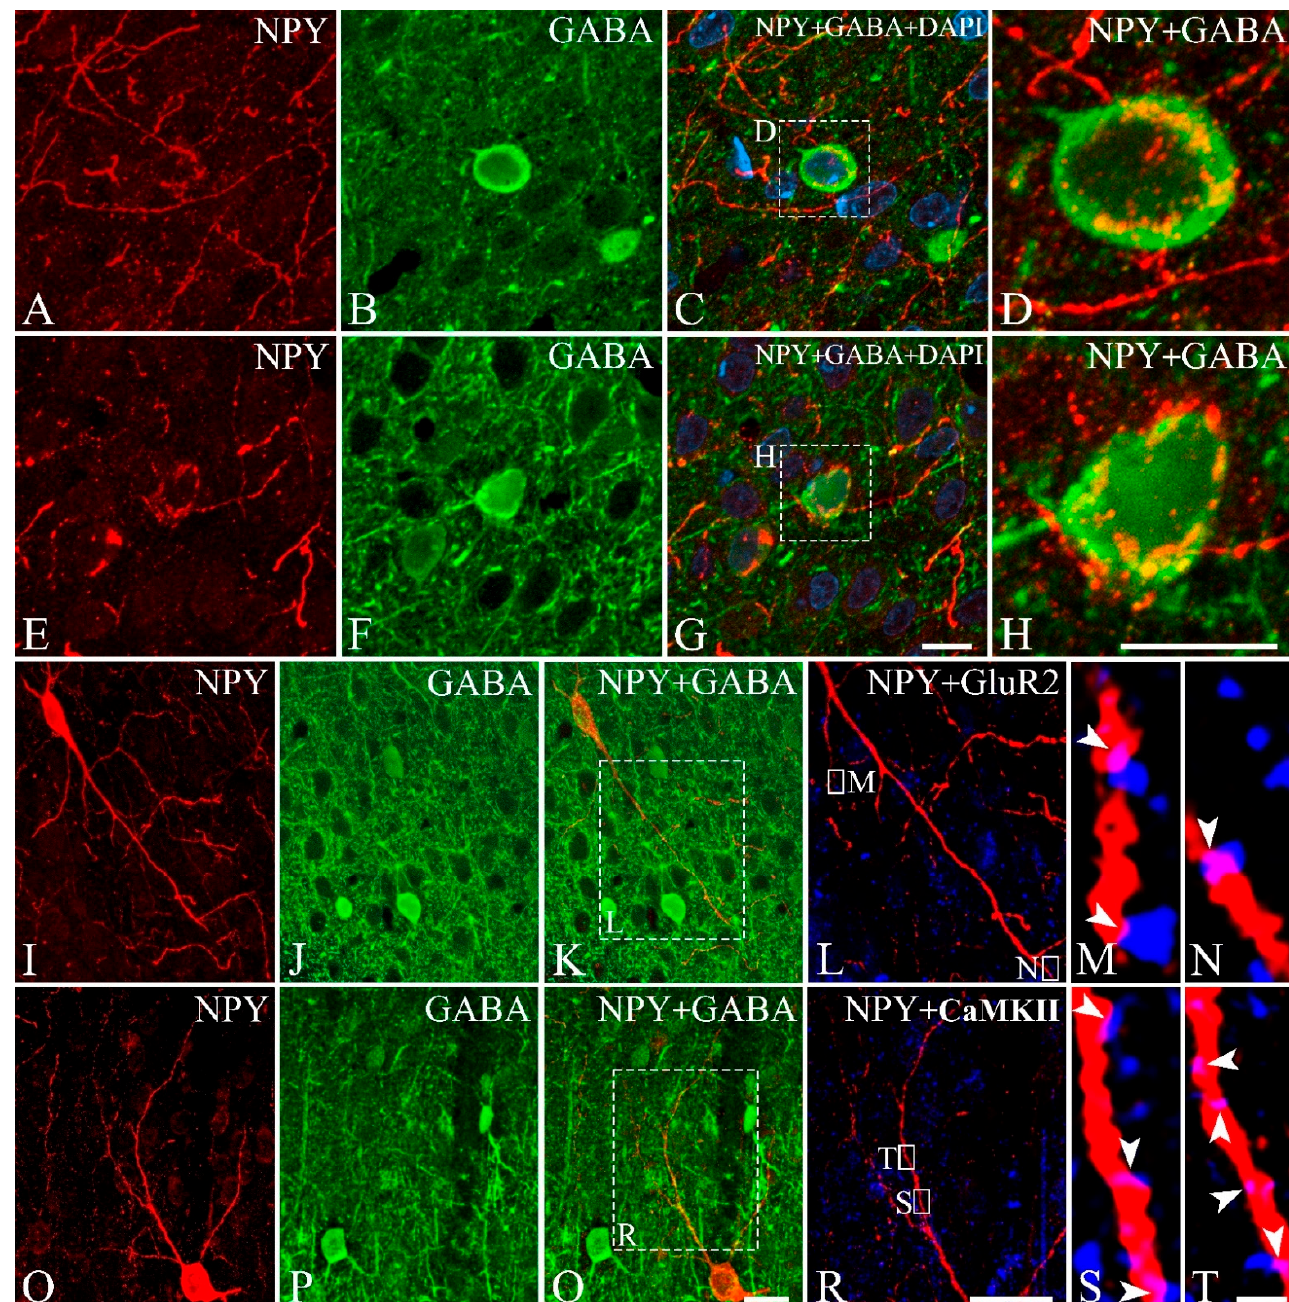
Figure 4. Double- and triple - labeling of NPY with GABA and GluR2 or CaMKII in the gerbil visual cortex. Expression of NPY (red, A , E , I , O ), GABA (green, B , F , J , P ), and GluR2 or CaMKII (blue represents the false color image of infrared fluorescence) in gerbil visual cortex. ( C , G ) Merged images of fluorescence NPY-IR fibers and GABA-IR neurons with 4 ′ ,6- diamidino-2-phenylindole (DAPI) staining. ( D , H ) Magnified images of boxes in C and G showing NPY-IR fibers surrounding the somata of GABA-IR neurons. ( K , Q ) Merged images of NPY-IR neurons which are not GABA-IR neurons. Magnified images of boxes in K and Q showing localization of NPY-IR fibers and GluR2- ( L ) or CaMKII-IR puncta ( R ). ( M , N , S , T ) Highly magnified images of boxes in L and R. NPY-IR fibers show colocalization (arrowheads, light pink) with GluR2- ( M , N ) or CaMKII-IR immunopuncta ( S , T ). A set of images NPY-IR fibers with GluR2- or CaMKII-IR immunopuncta was taken at single focal plane from the same field. Scale bar = 10 μ m ( G , H ), 20 μ m ( Q , R ), 1 μ m ( T ).